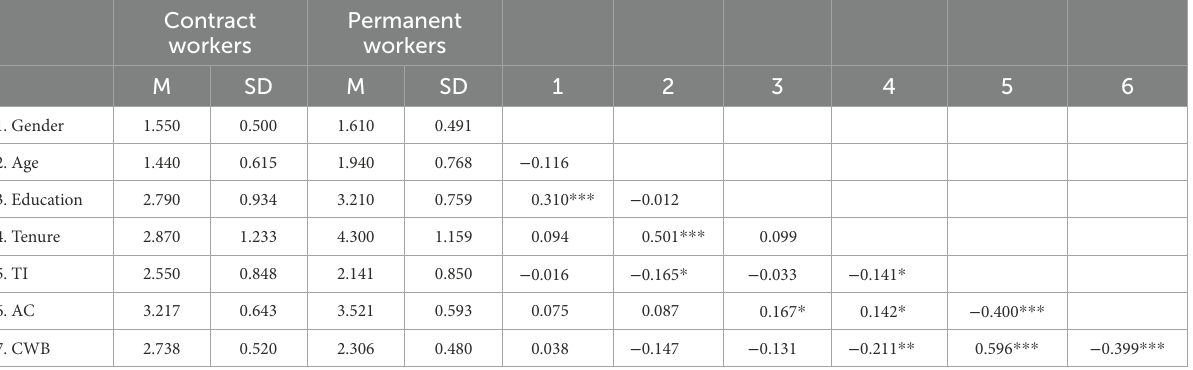
TABLE 1 Means, standard deviations, correlations of